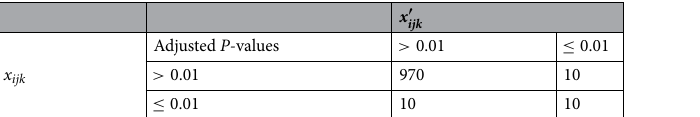
Table 12. Confusion matrix of selected i s between x ijk and x ′ ijk by KTD-based unsupervised FE applied to synthetic data set